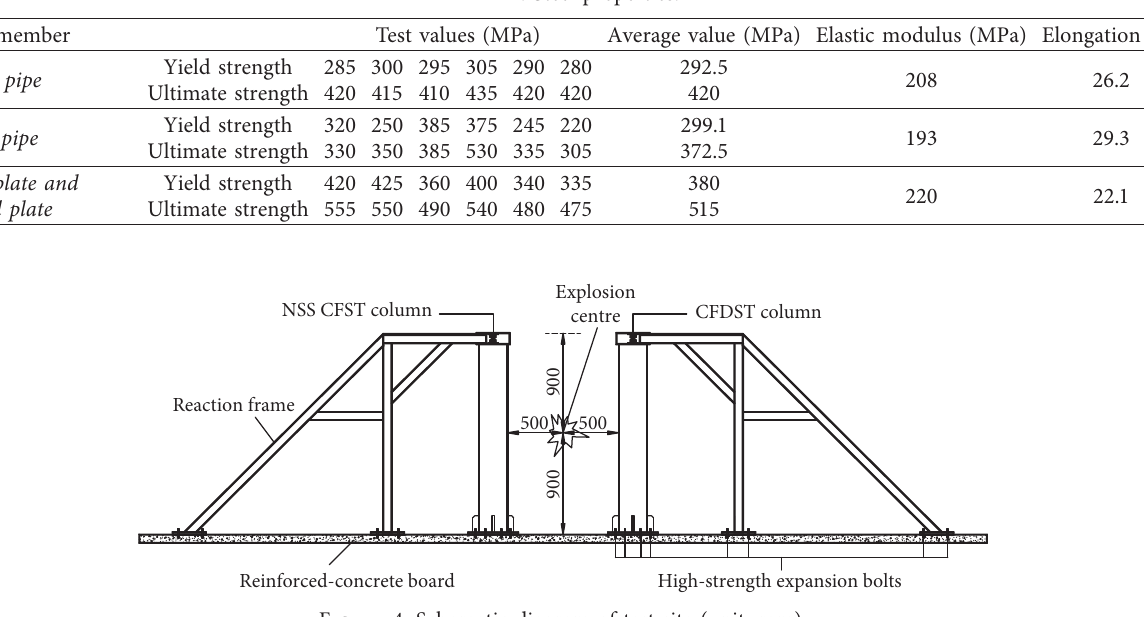
Figure 4: Schematic diagram of test site (unit: mm).